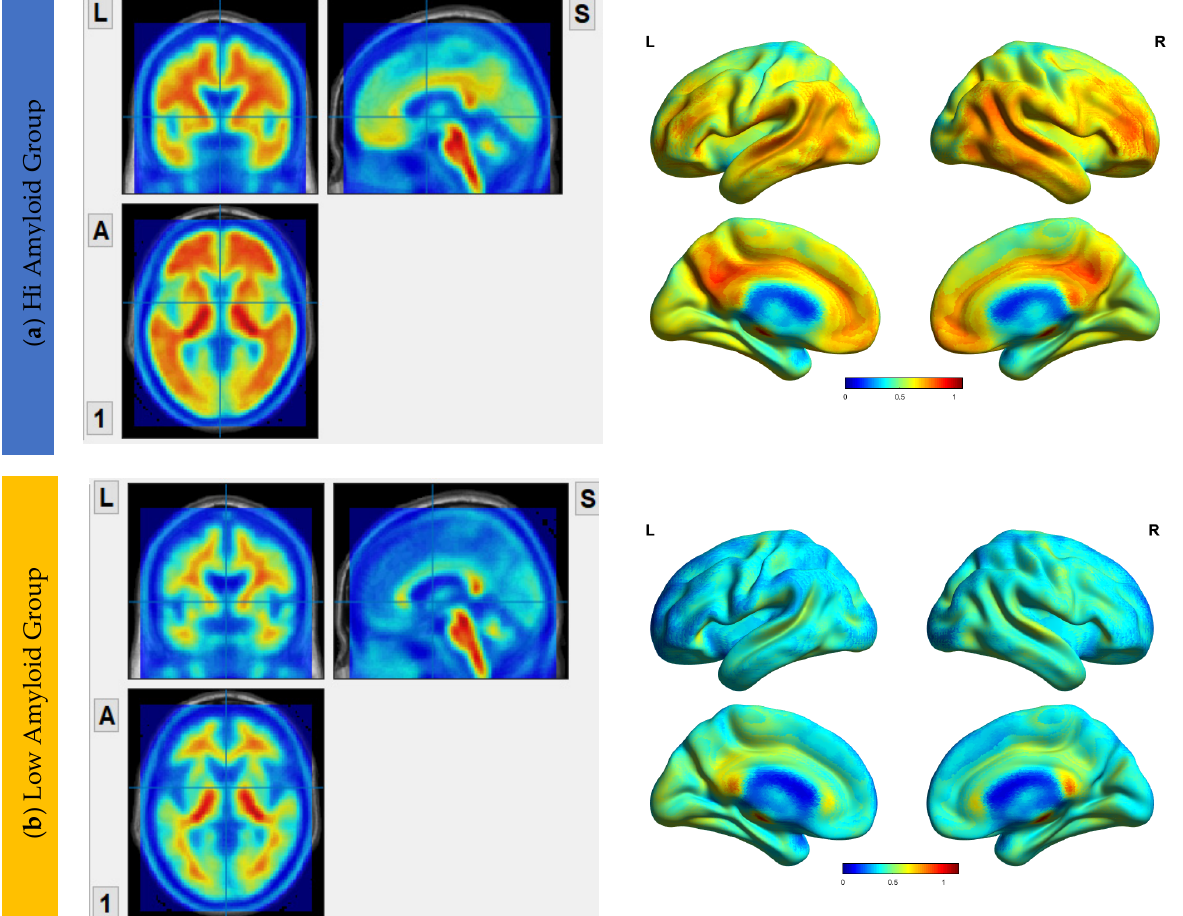
Figure 1. [ 18 F]flutemetamol PET/CT imaging showing A β protein accumulation (SUVr) Maps, showing regions of A β accumulations from voxel-wise analysis. ( a ) shows the regions where A β protein distribution in the HiAmy group. ( b ) shows the regions where A β protein distribution in the LowAmy group. The voxel-wise map is adjusted for age and sex. The blue and red colours illustrate the SUVr values according to the scale on the right. When compare Figure 1a,b, the A β protein accumulation was much higher in the HiAmy group when compared to the LowAmy group. Hi-